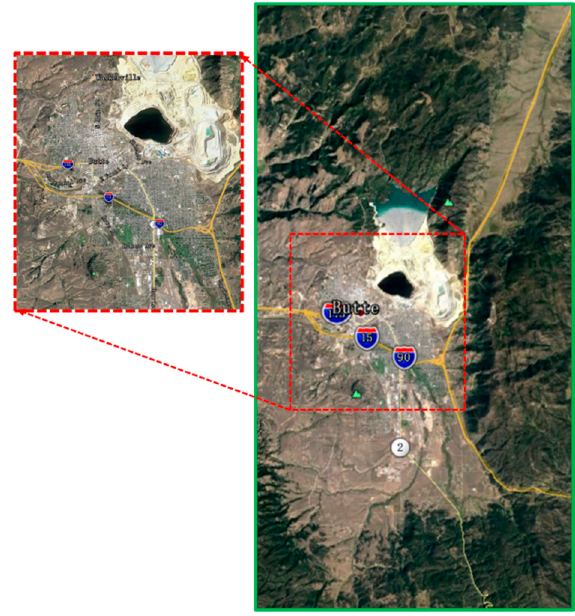
Figure 10. The satellite map of the Butte area in Google Maps.